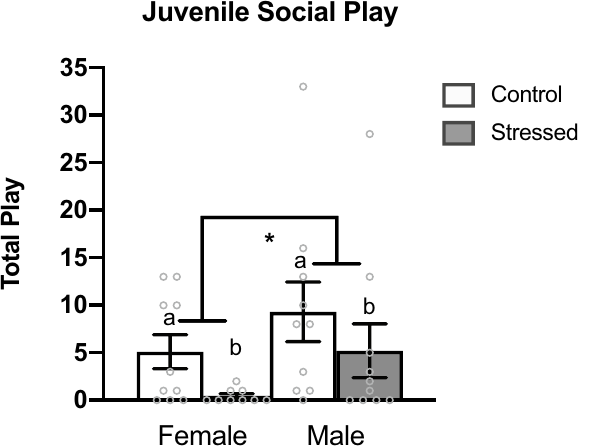
Figure 1. Juvenile social play behavior. Early life stress reduces juvenile social play behavior in males and females. Juvenile males play at higher levels than juvenile females. Values shown as mean ± SEM. *Indicates p <